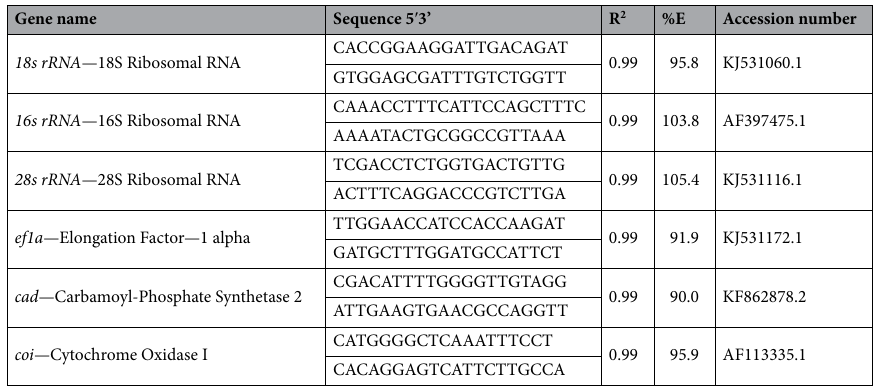
Table 2. Six candidate reference genes, with their qPCR primer sequence, R 2 correlation coefficient, percent primer efficiency, and accession